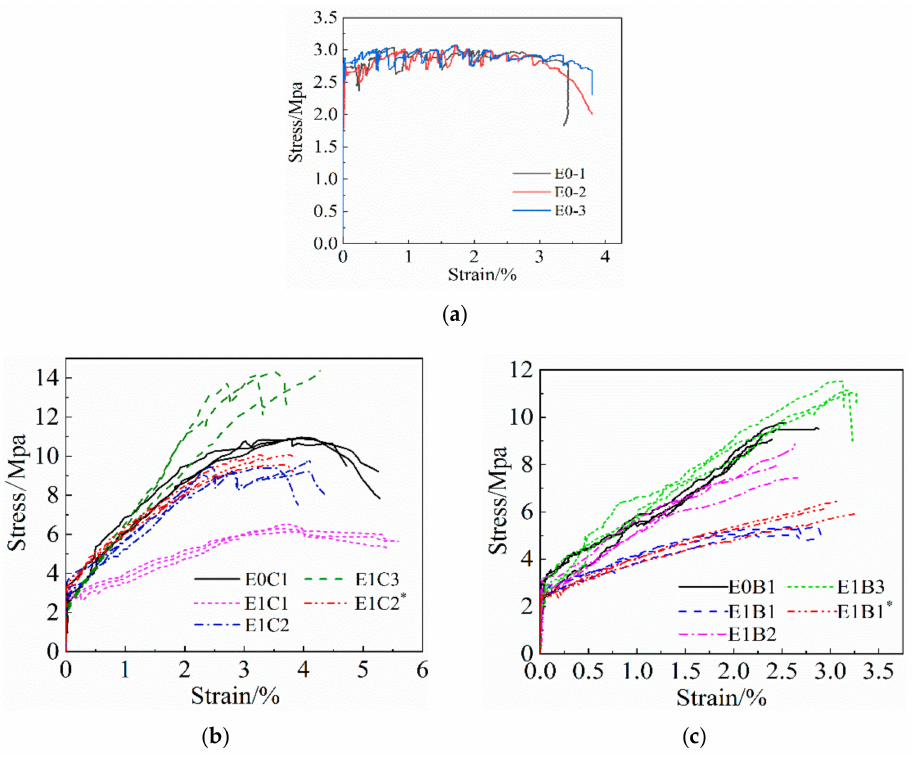
Figure 5. Specimen axial tensile stress–strain curve. ( a ) ECC specimen set, ( b ) CFRP grid-reinforced ECC specimen set, ( c ) BFRP grid-reinforced ECC